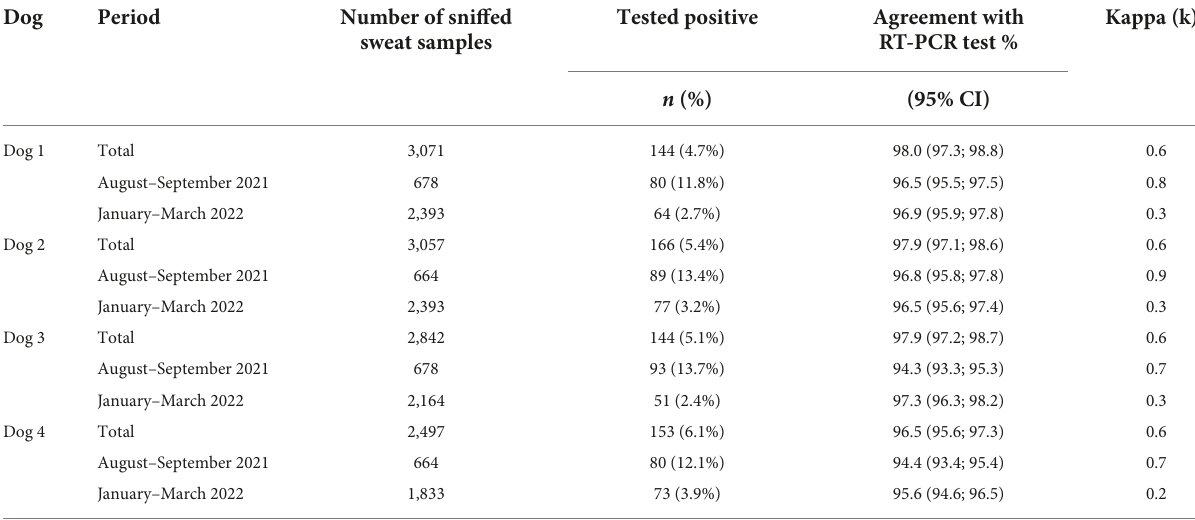
Number of sniffed Tested positive Agreement with sweat samples RT-PCR test